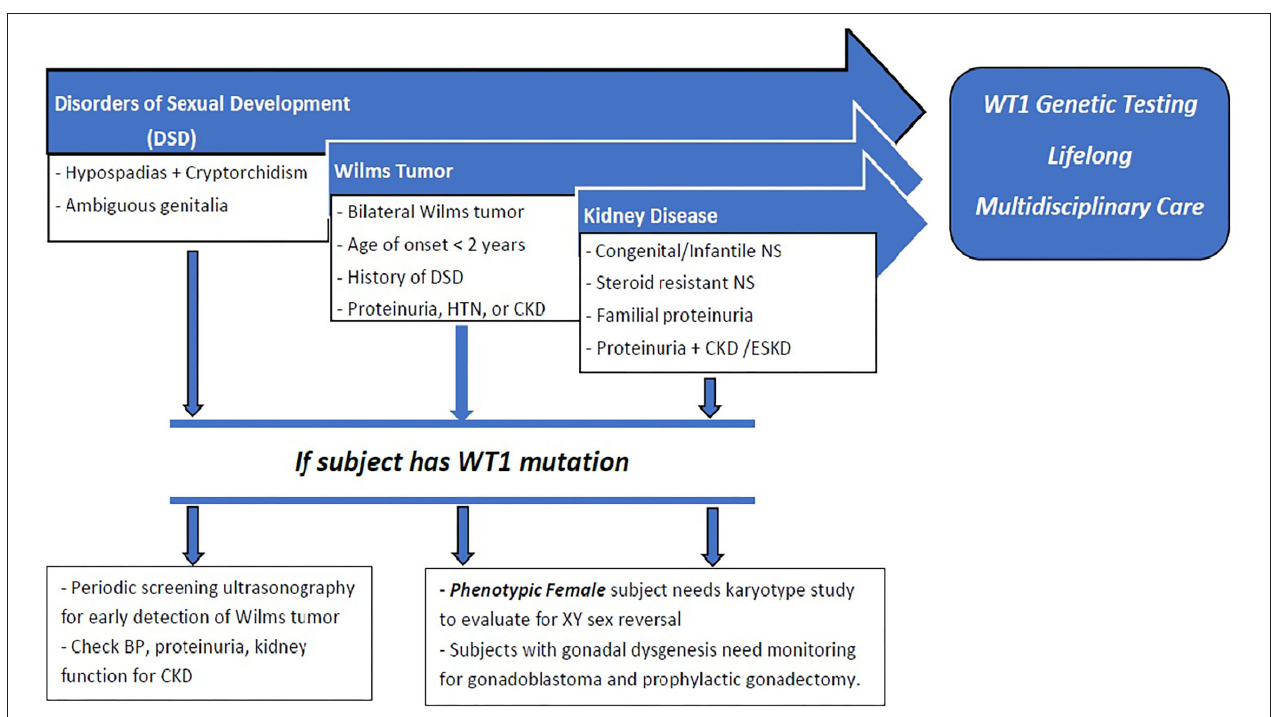
FIGURE 4 | : Proposed paradigm for early recognition, comprehensive genetic testing followed by clinical surveillance of patients with WT1 mutation . Early presentation with DSD, CNS, SRNS, or Wilm’s tumor should raise suspicion for WT1 mutation . Those with DSD should undergo periodic screening for Wilm’s tumor, proteinuria, and development of CKD. All phenotypic females should have karyotype testing for possible 46XY sex reversal. All patients with WT1 mutation should receive long-term multidisciplinary medical, surgical, and psychosocial management. Phenotypic females with XY sex reversal should be closely surveilled for gonadoblastoma and recommended for prophylactic